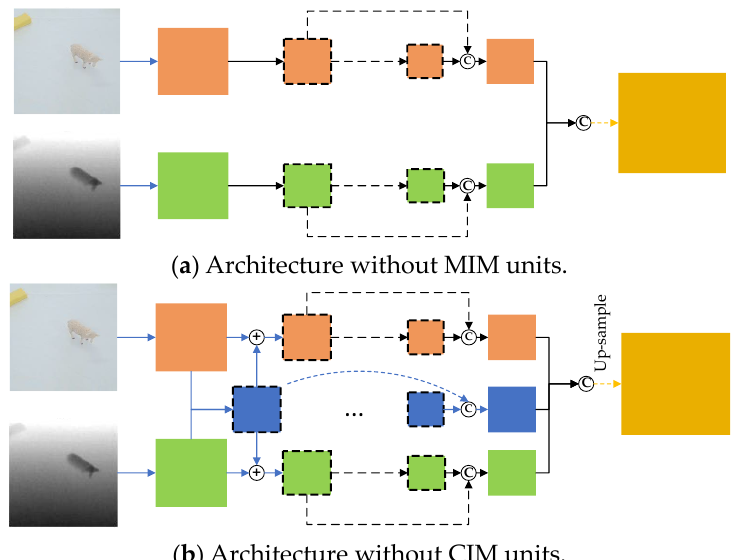
Figure 13. Architectures in ablation experiments: ( a ) has no MIM blocks; and ( b ) has no CIM blocks.